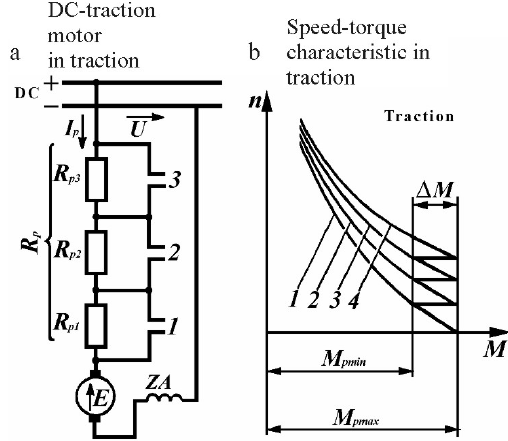
Fig 6. A circuit diagram of rheostat starting (traction mode) of DC series excitation motor (a) and its speed-torque characteristic n = f ( M ) (b): R p 1 , R p 2 , R p 3 – additional